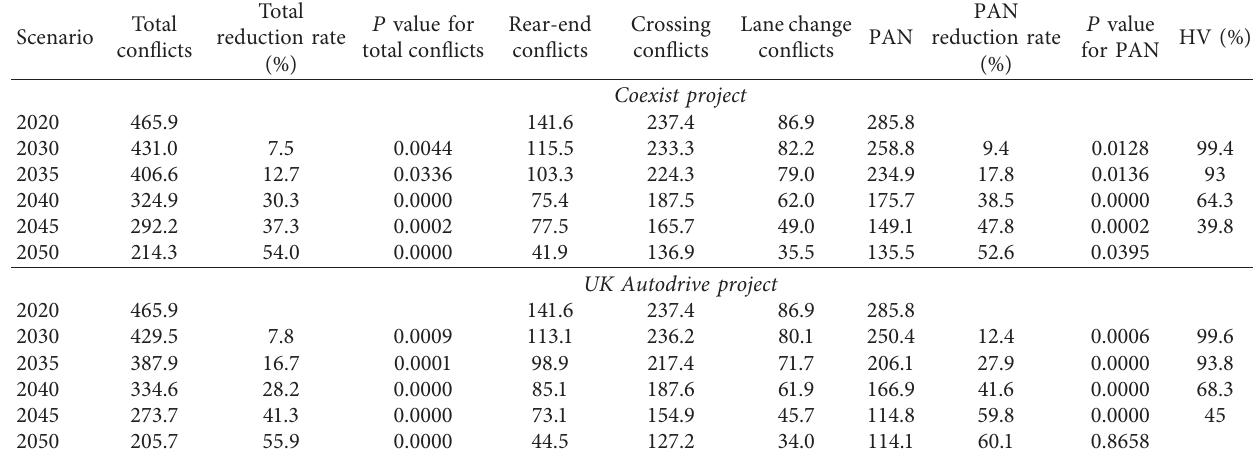
Table 5: Conflict results for Vesal intersection with the real-world demand.